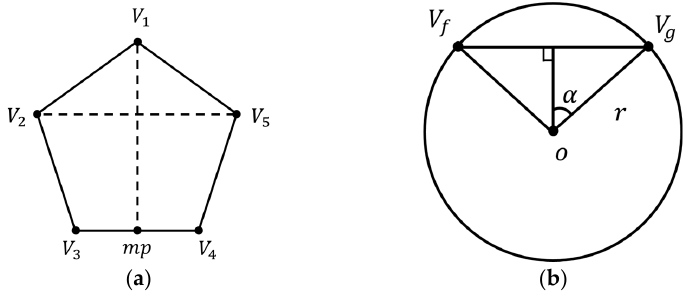
Figure 7. Illustration of width and height of the viewing range for the dodecahedron. ( a ) Width and height of viewing range; ( b ) Cross section of the sphere.